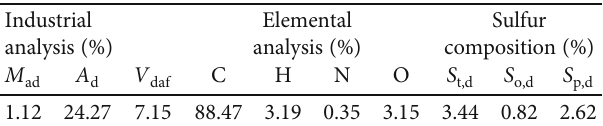
Table 1: Experimental sample parameter determination numerical